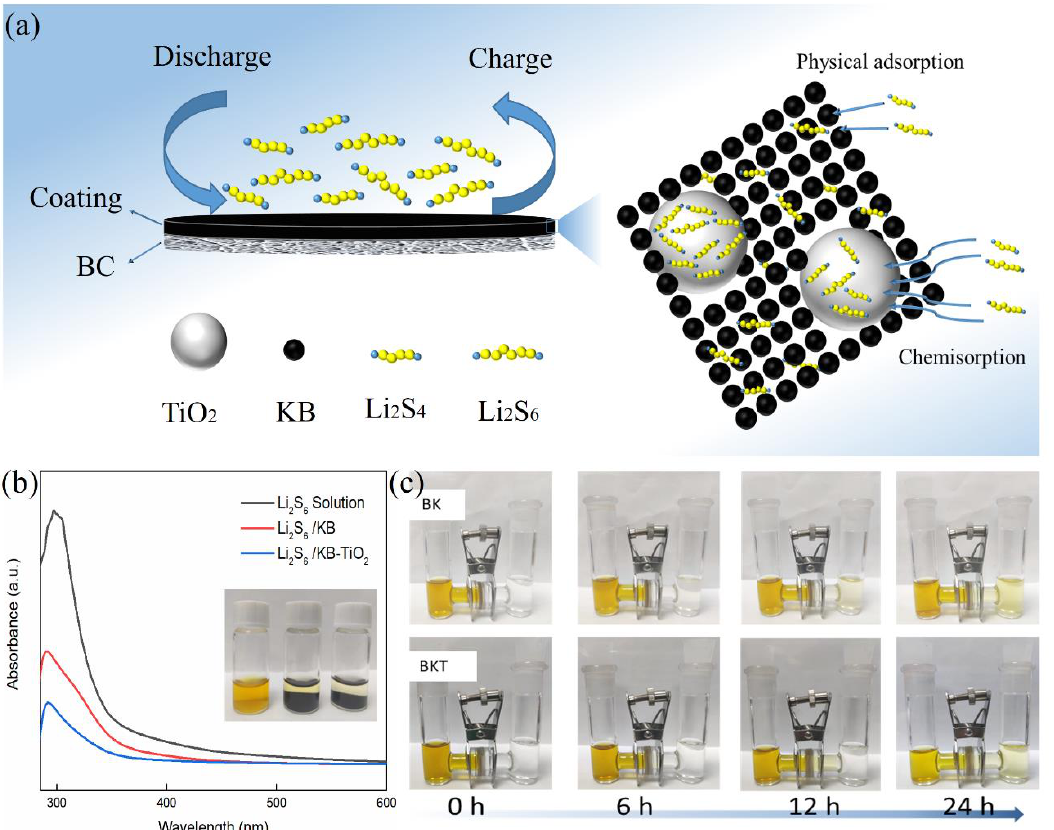
Figure 2. ( a ) Schematic diagram of BKT separator blocking LiPSs during charge and discharge; ( b ) KB-TiO 2 composite material after adsorption of Li 2 S 6 12 h photo and its UV – Vis spectrum; ( c ) BKT separator and BK separator H-type electrolytic cell Inhibition of Li 2 S 6 diffusion performance graph.